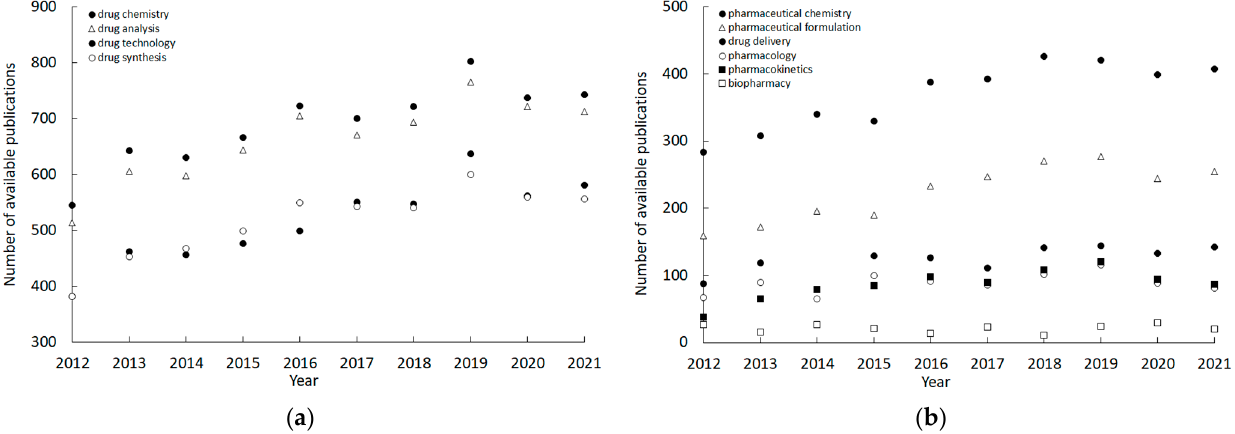
Figure 2. The number of available publications in the fields which add to over 50% coverage of the application of Langmuir balance ( a ), and below 50% coverage of the application of Langmuir balance ( b ).